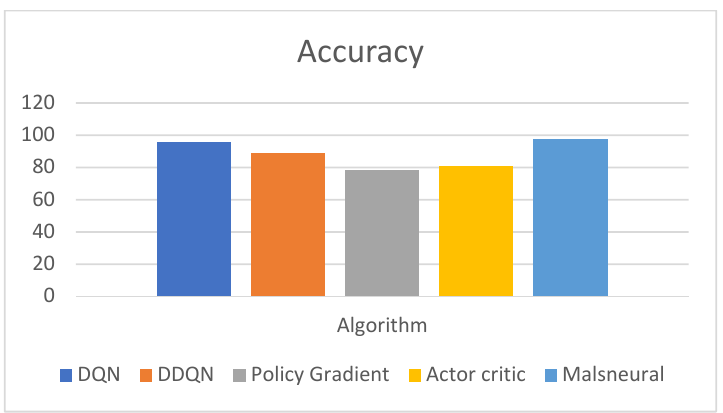
Figure 17. Confusion matrix for monkeypox disease classification.